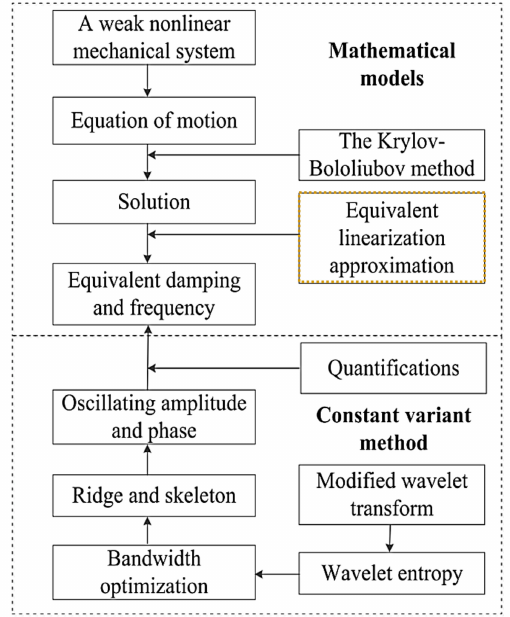
Figure 4. A diagram for nonlinearity identification of weakly nonlinear systems